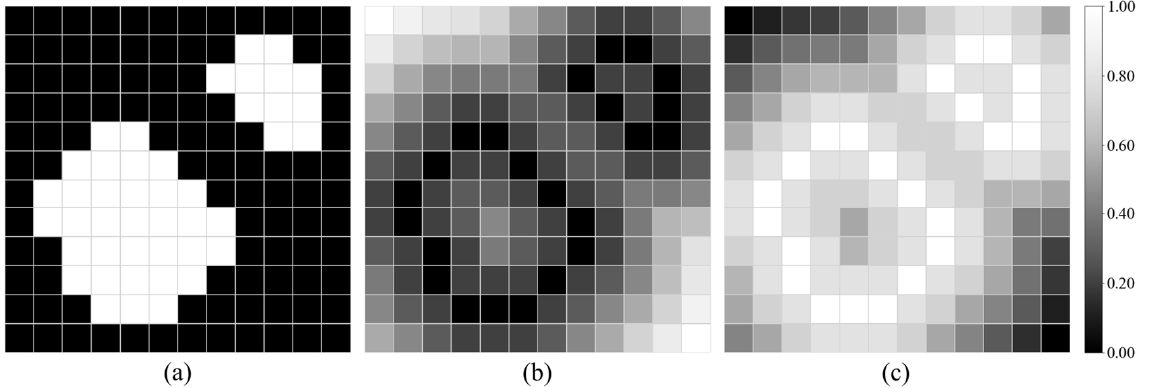
Figure 3. Distance maps for loss weighting. ( a ) Label image, ( b ) distance transform map, and ( c ) distance penalty term.